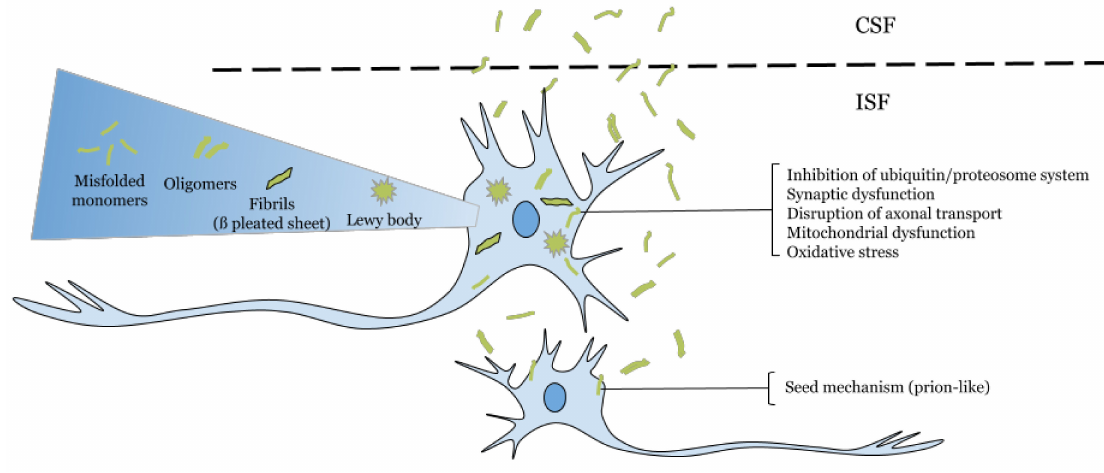
Figure 1. Effects of intracellular and extracellular alpha-synuclein.